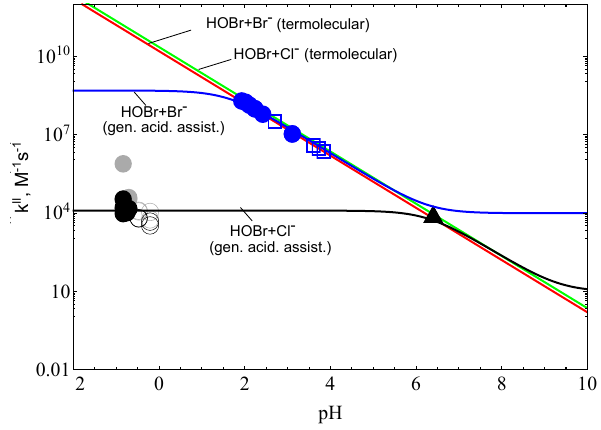
Figure 1. Second-order rate constants for the reaction of HOBr with Br − and Cl − as a function of pH. Experimental estimates for k II for HOBr + Br − derived from data from Eigen and Kustin (1962) and Beckwith et al. (1996) (blue squares and circles respectively) are shown alongside model estimate (blue line) according to the acid-assisted mechanism. The red line denotes the k II rate con- stant assuming termolecular kinetics across all pH. Experimen- tal estimates for k II for HOBr + Cl − derived from data from Liu and Margarem (2001) at pH = 6.4 (black triangle) and Pratte and Rossi (2006) at pH − 1 to 0 (black and grey discs for data at RH = 77–80%, open circles for RH = 85–90%), are shown along- side model estimate (black line) according to the general acid- assisted mechanism. The green line denotes the k II rate constant assuming termolecular kinetics across all